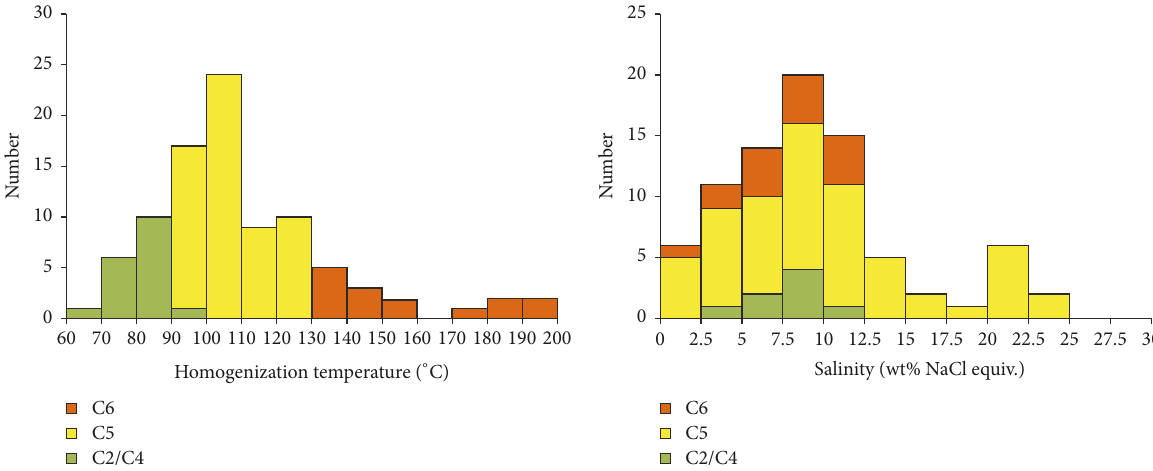
Figure 10: Histograms showing homogenization temperatures and salinities measured from fluid inclusions of different stages of pore-filling calcite